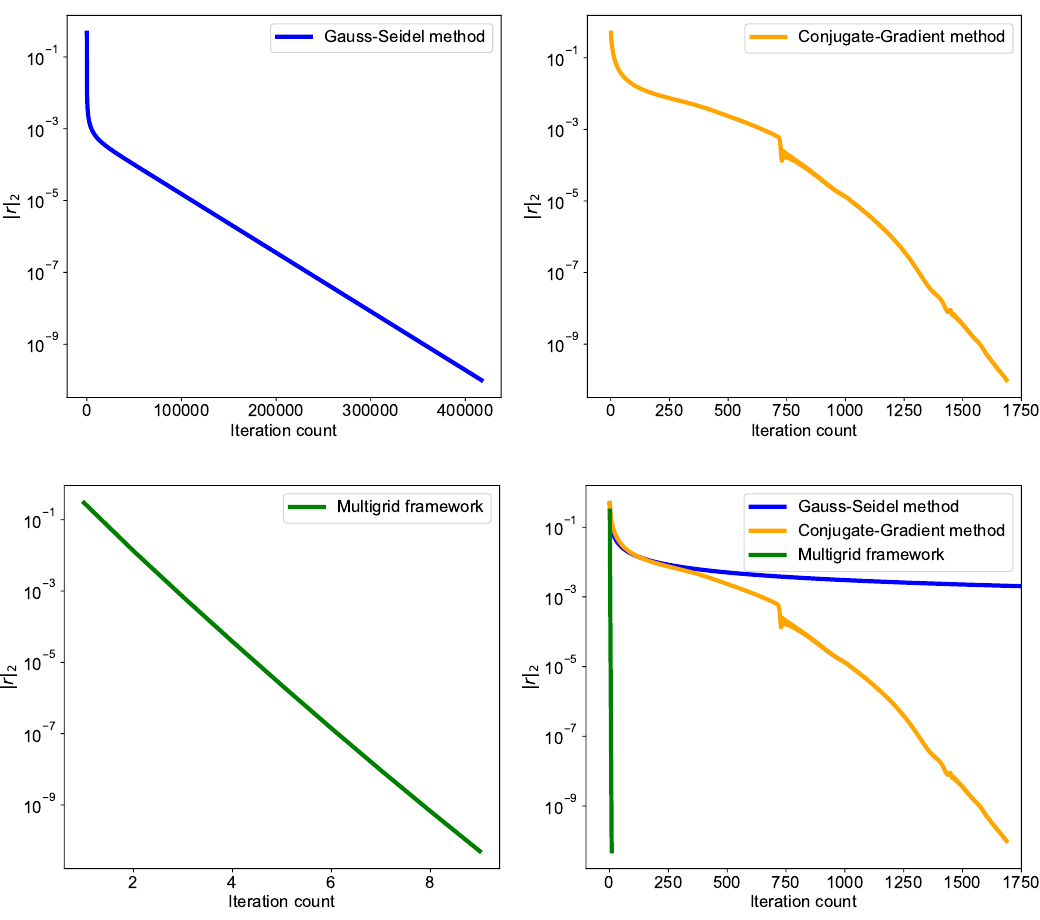
Figure 24. Residual history comparison for different iterative methods for Poisson equation with Dirichlet boundary condition. The stopping criteria for all iterative methods is that the residual should reduce below 10 − 10 . The grid resolution for all cases is N x = 512 and N y =